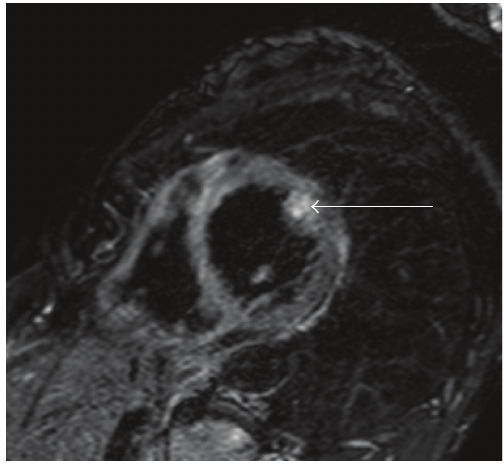
Figure 3: 25-year-old male with acute myocarditis. T2-weighted MRI shows myocardial edema associated with acute myocarditis (arrows). The edema predominantly involves the epicardial or transmural myocardium in the lateral wall.